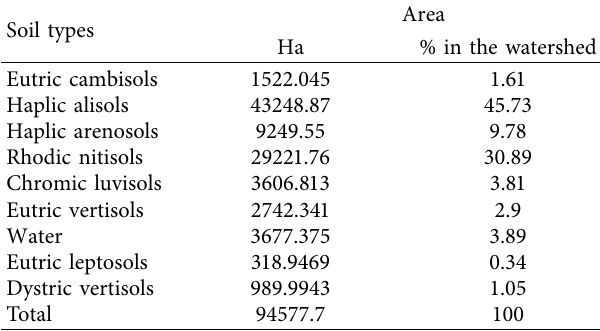
Table 4: Slope classes of the Nashe